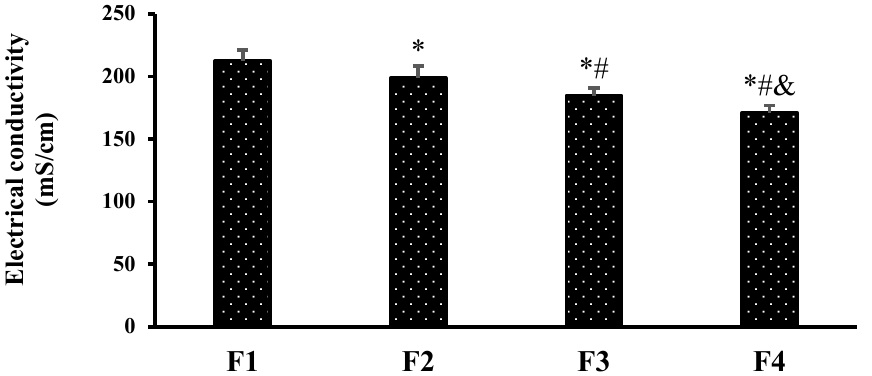
Figure 3. The electrical conductivity of hemp seed nanoemulsion formulations. *: versus formula- tion 1 (F1), #: versus F2, and &: versus F3 at p < 0.05.